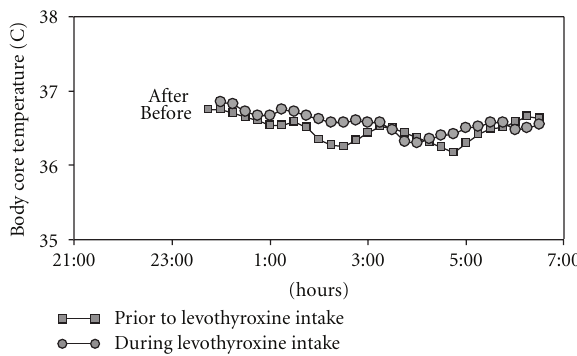
Figure 1: Time course of core body temperature in a male subject prior to (grey square) and during (grey circle) levothyroxine